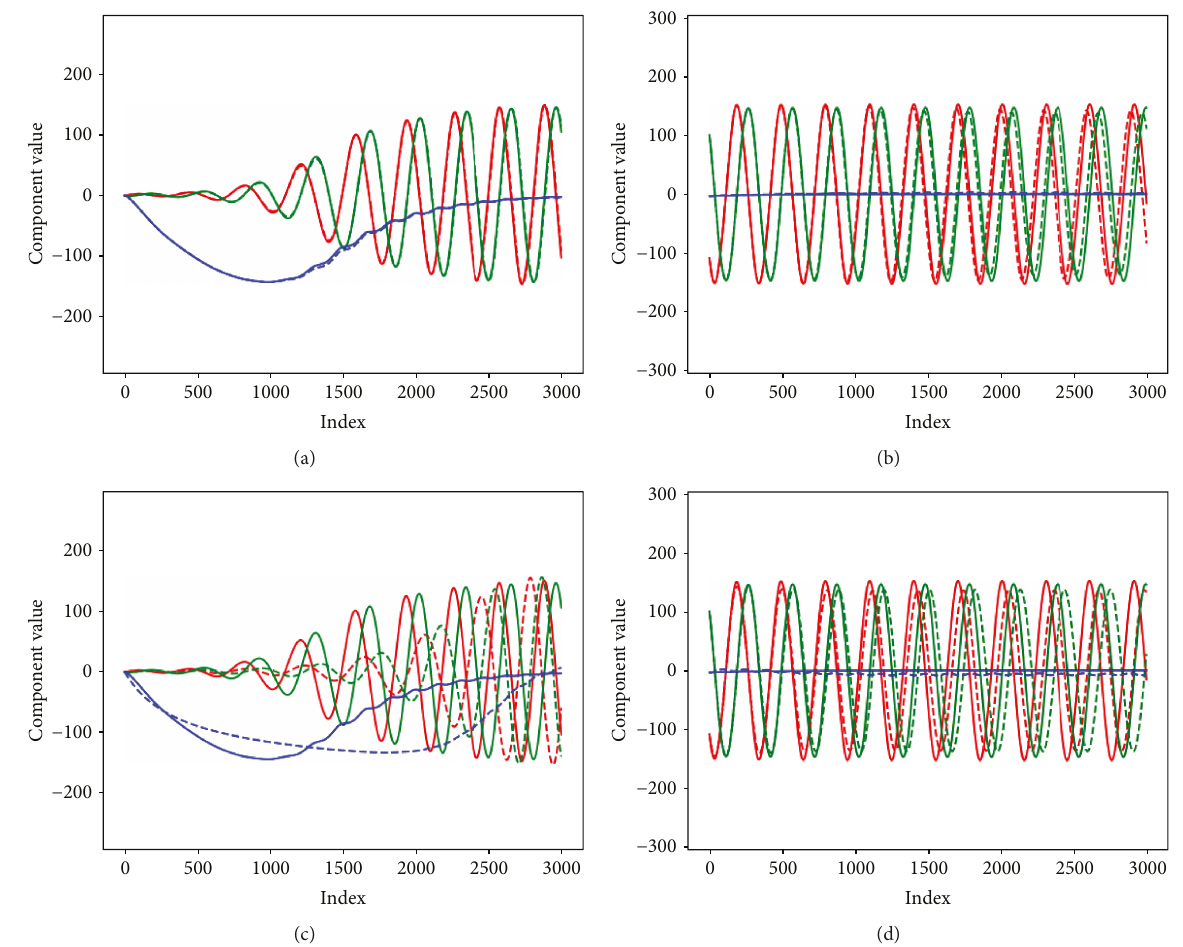
Figure 14: A posteriori comparison for fl ow in a cylinder wake between the basic model and SINDy. Red: fi rst POD coe ffi cient. Green: second POD coe ffi cient. Blue: shift-mode coe ffi cient. (a, b) Basic model. (c, d) SINDy. (a, c) Training data. (b, d) Testing